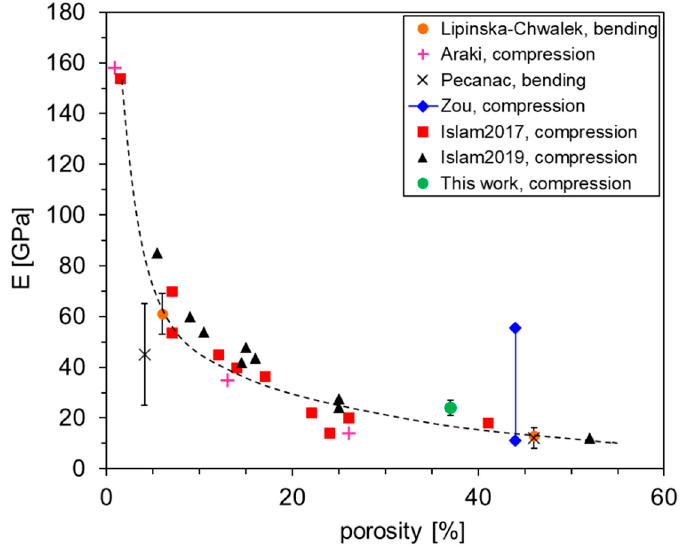
Figure 12. Elastic module measured on the asymmetric LSCF samples of this work compared with results previously reported in literature at RT for porous specimens. The values are grouped with respect to the first author and the characterization technique. The dashed line serves only as an eye guideline.